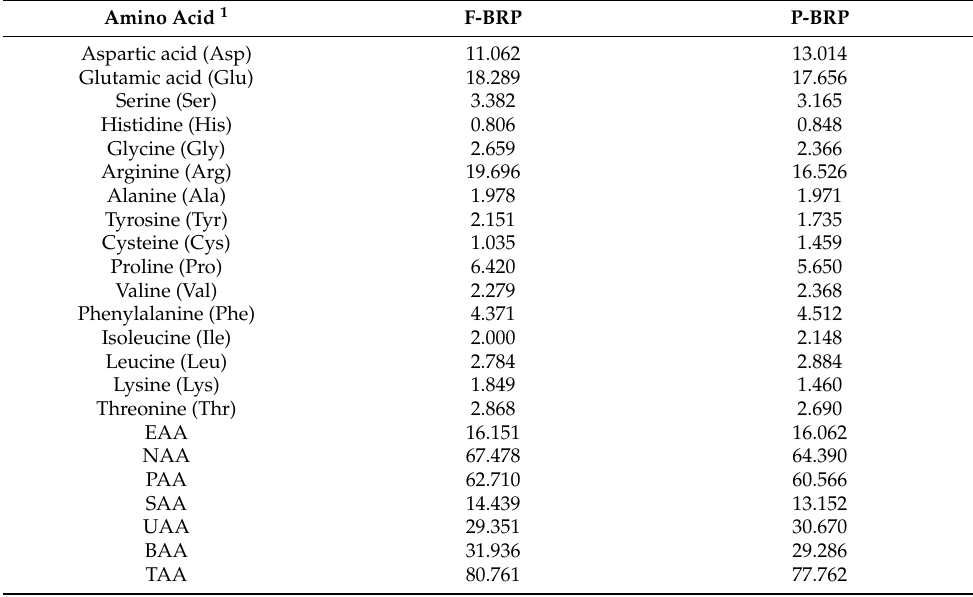
Table 1. Amino acid content of burdock root samples in Fengxian and Peixian. Amino Acid 1 F-BRP P-BRP Aspartic acid (Asp)